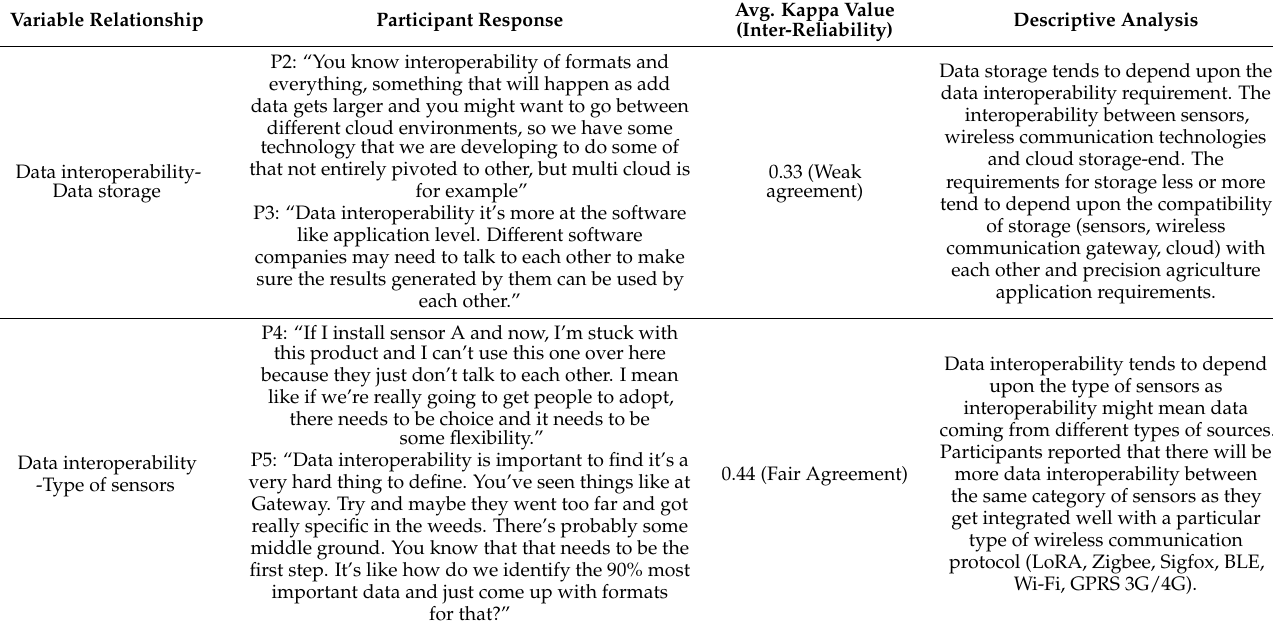
Table 1. Variable Relationships and Descriptive Content